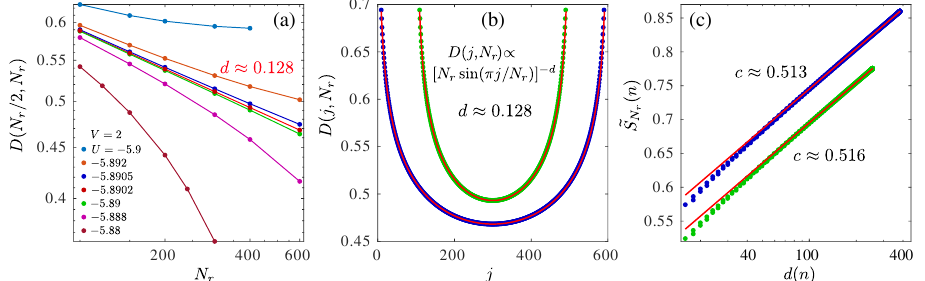
Figure 10: Numerical evidence in favor of an Ising transition in the hard-boson model. (a) Finite-size scaling of the dimerization computed in the middle of the chain with free boundary conditions. The quantum critical point for V = 2 corre- sponds to the straight line at U ≈ − 5.8902. The corresponding critical exponent d ≈ 0.128 agrees within 3% with the Ising prediction 1 / 8. (b) Decay of the Friedel oscillations away from the edges (see main text for boundary conditions). The crit- ical exponent again agrees within 3% with the Ising prediction 1 / 8. (c) Scaling of the reduced entanglement entropy with the conformal distance. The value obtained for the central charge agrees with the Ising prediction c = 1 / 2 within